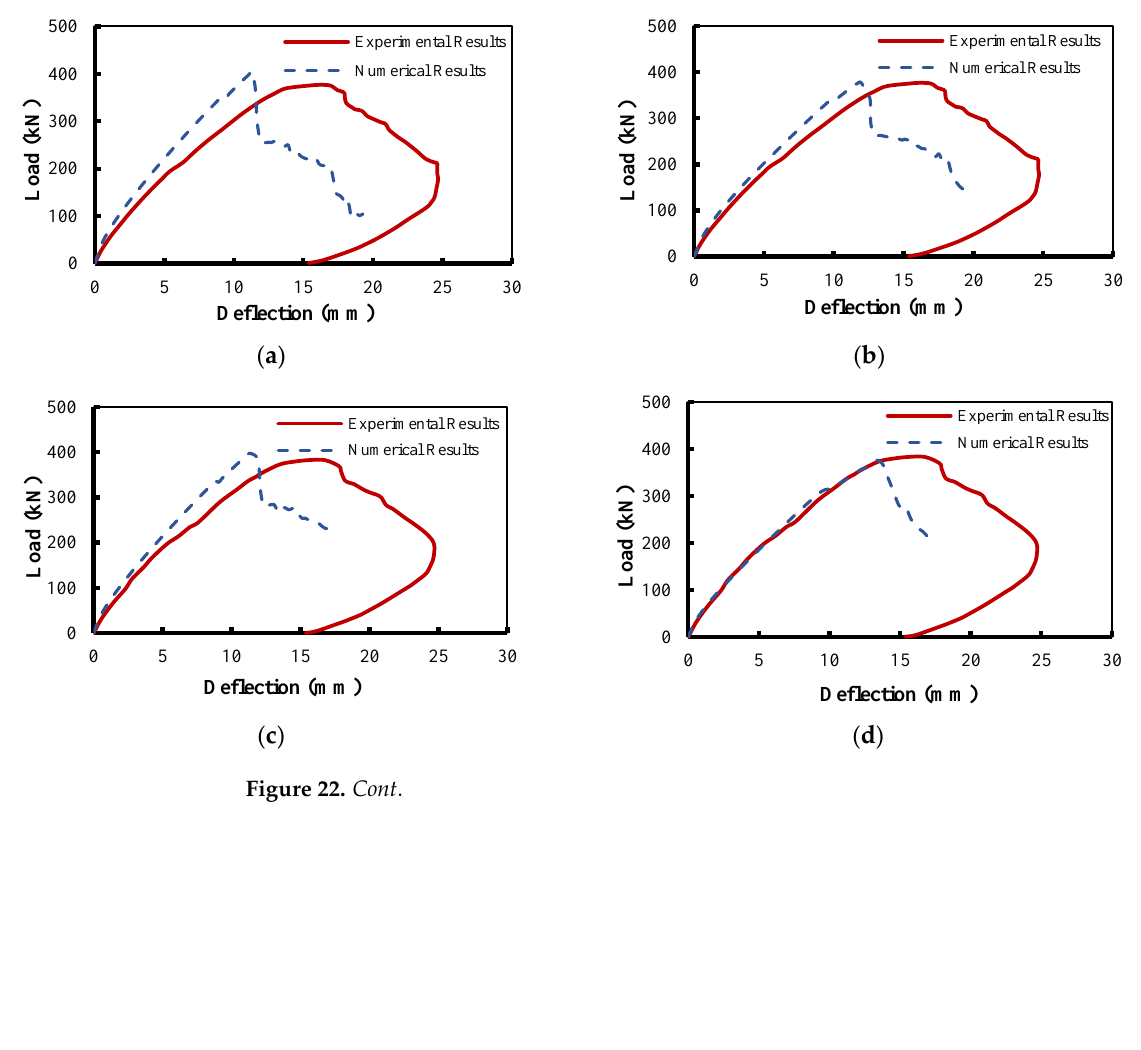
Figure 21. Crack Information of Specimen (CBA): ( a ) Crack Width and ( b ) Crack Spacing.